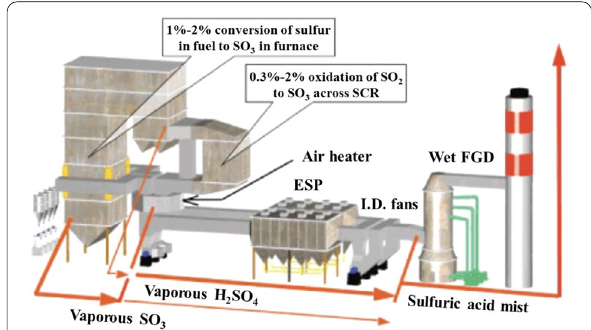
Fig. 4 Oxidation of SO 2 to SO 3 in a boiler and SCR (Electric Power Research Institute) [18]. ESP electrostatic precipitator, FGD flue gas desulfurization system, I.D induced‑draft, SCR selective catalytic reduction system.